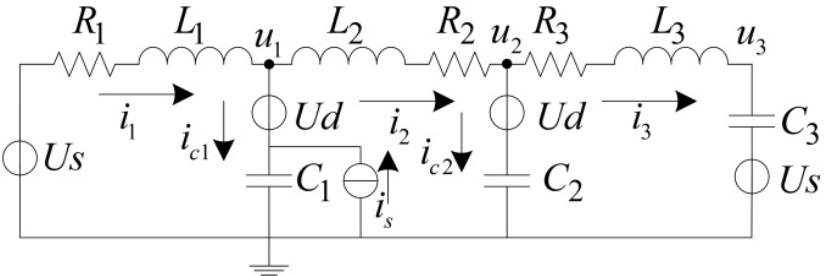
Figure 2. Equivalent circuit model of the inkjet print-head.